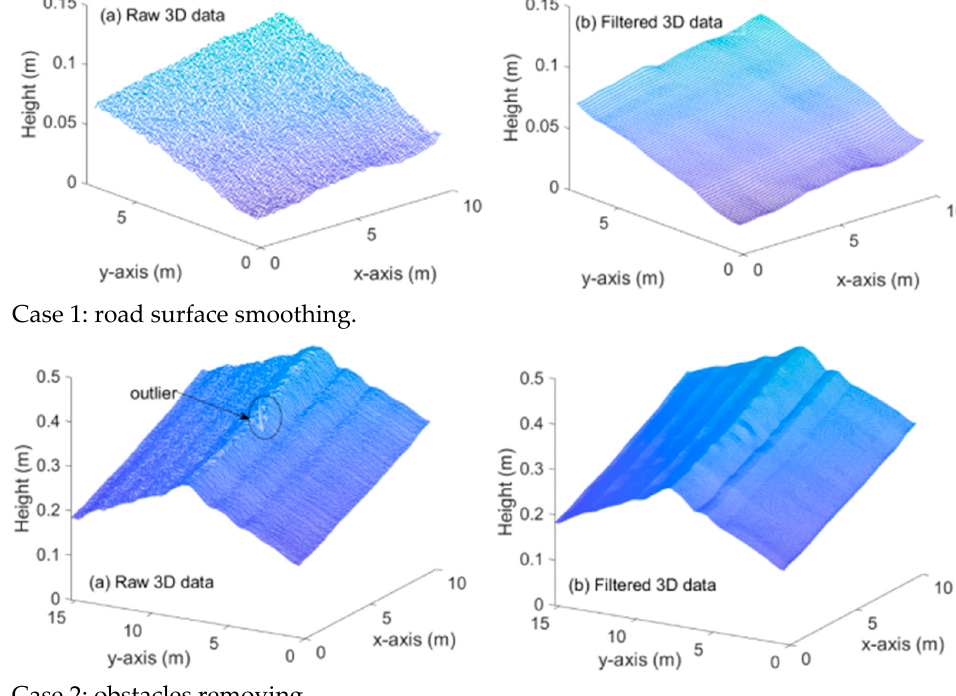
Figure 6. Raw 3D data and filtered 3D data of Case 1(a,b) and Case 2